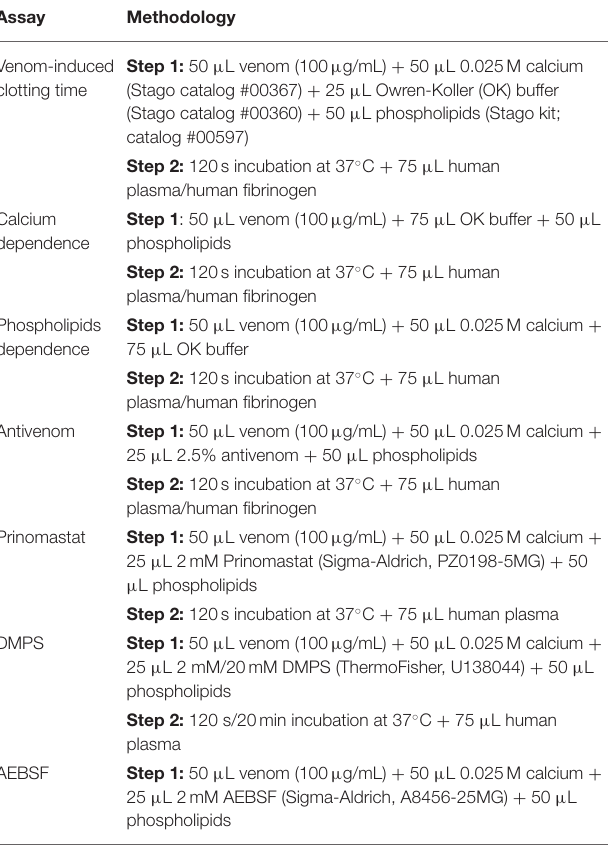
TABLE 1 | Overview of coagulation assays performed on STA-R Max hemostasis analyzer. Assay